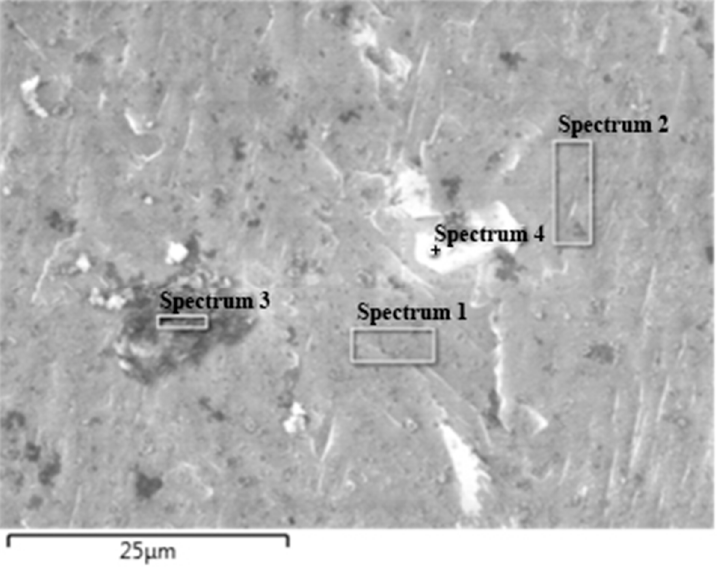
Figure 5. SEM images of the sample surfaces. ( a ) Sample 1, ( b ) Sample 2.